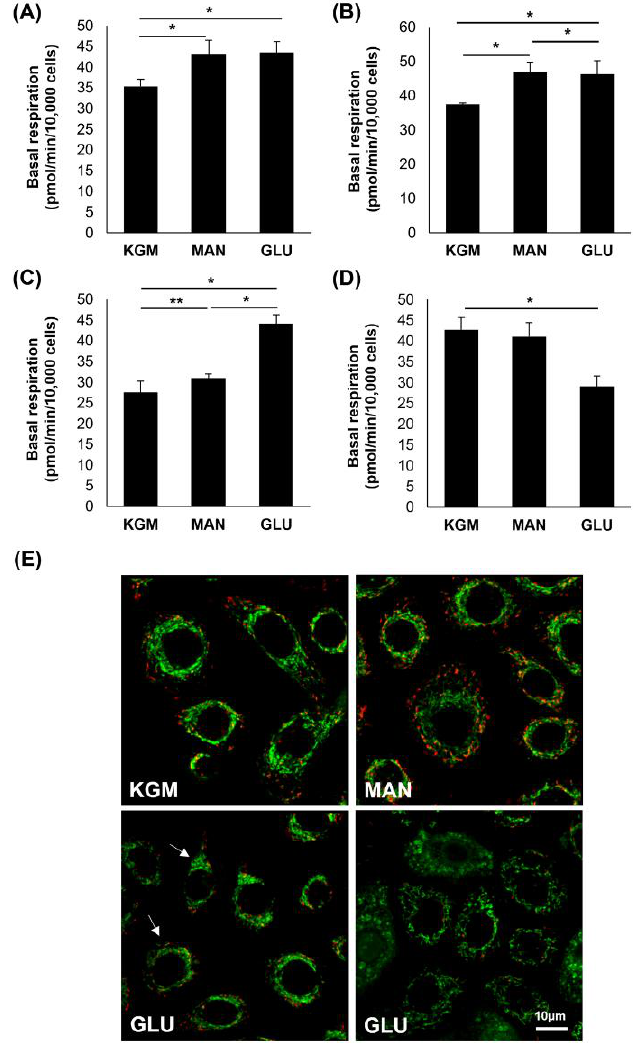
Figure 6. Basal respiration was increased in acute but decreased in chronic hyperglycemic culture. ( A ) Basal respiration showed an early increase in response to osmotic stress at 24 hours (* p < 0.001). ( B ) Basal respiration remained increased in response to hyperosmolarity at 5 days (* p < 0.001). ( C ) After 9 days, basal respiration was increased in response to hyperglycemia (* p < 0.001, ** p = 0.011). ( D ) By day 14, basal respiration was significantly decreased in high glucose compared to KGM (* p < 0.001). ( E ) After 14 days, JC-1 labeling of cells cultured in KGM showed polarized mitochondria with normal morphology (JC-1 monomers, green; JC-1 aggregates indicating polarization, red). Cells cultured in mannitol were similar to the KGM control. In high glucose, there was a mixed population of cells with decreased polarization and occasional ring-donut-shaped mitochondria (arrows) or more perinuclear accumulation. Scale bar: 10 mm. Images are representative of 3 repeated experiments. Data in graphs are presented as mean ± standard deviation. Graphs are representative of one experiment that was repeated three independent times. One-way ANOVA on ranks with Dunn’s post hoc comparison test (14 days) ( D ) and one-way ANOVA with SNK multiple comparison test for all others.